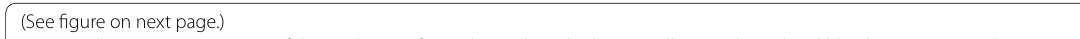
sediments(See figure on next Fig. 4 Schematic cross-section of the evolution of a wedge with multiple BTH collisions. The red and blue lines represent the active and inactive décollements, respectively. Colored units (gray, brown, green, and blue) represent each BTH collisional unit bounded by the old and new décollements. The yellow strata are the underthrust sediments behind the BTH. Enlarged schematic illustrations of the strata represent the mechanical and hydrological conditions (Fig. 5) in the underthrust